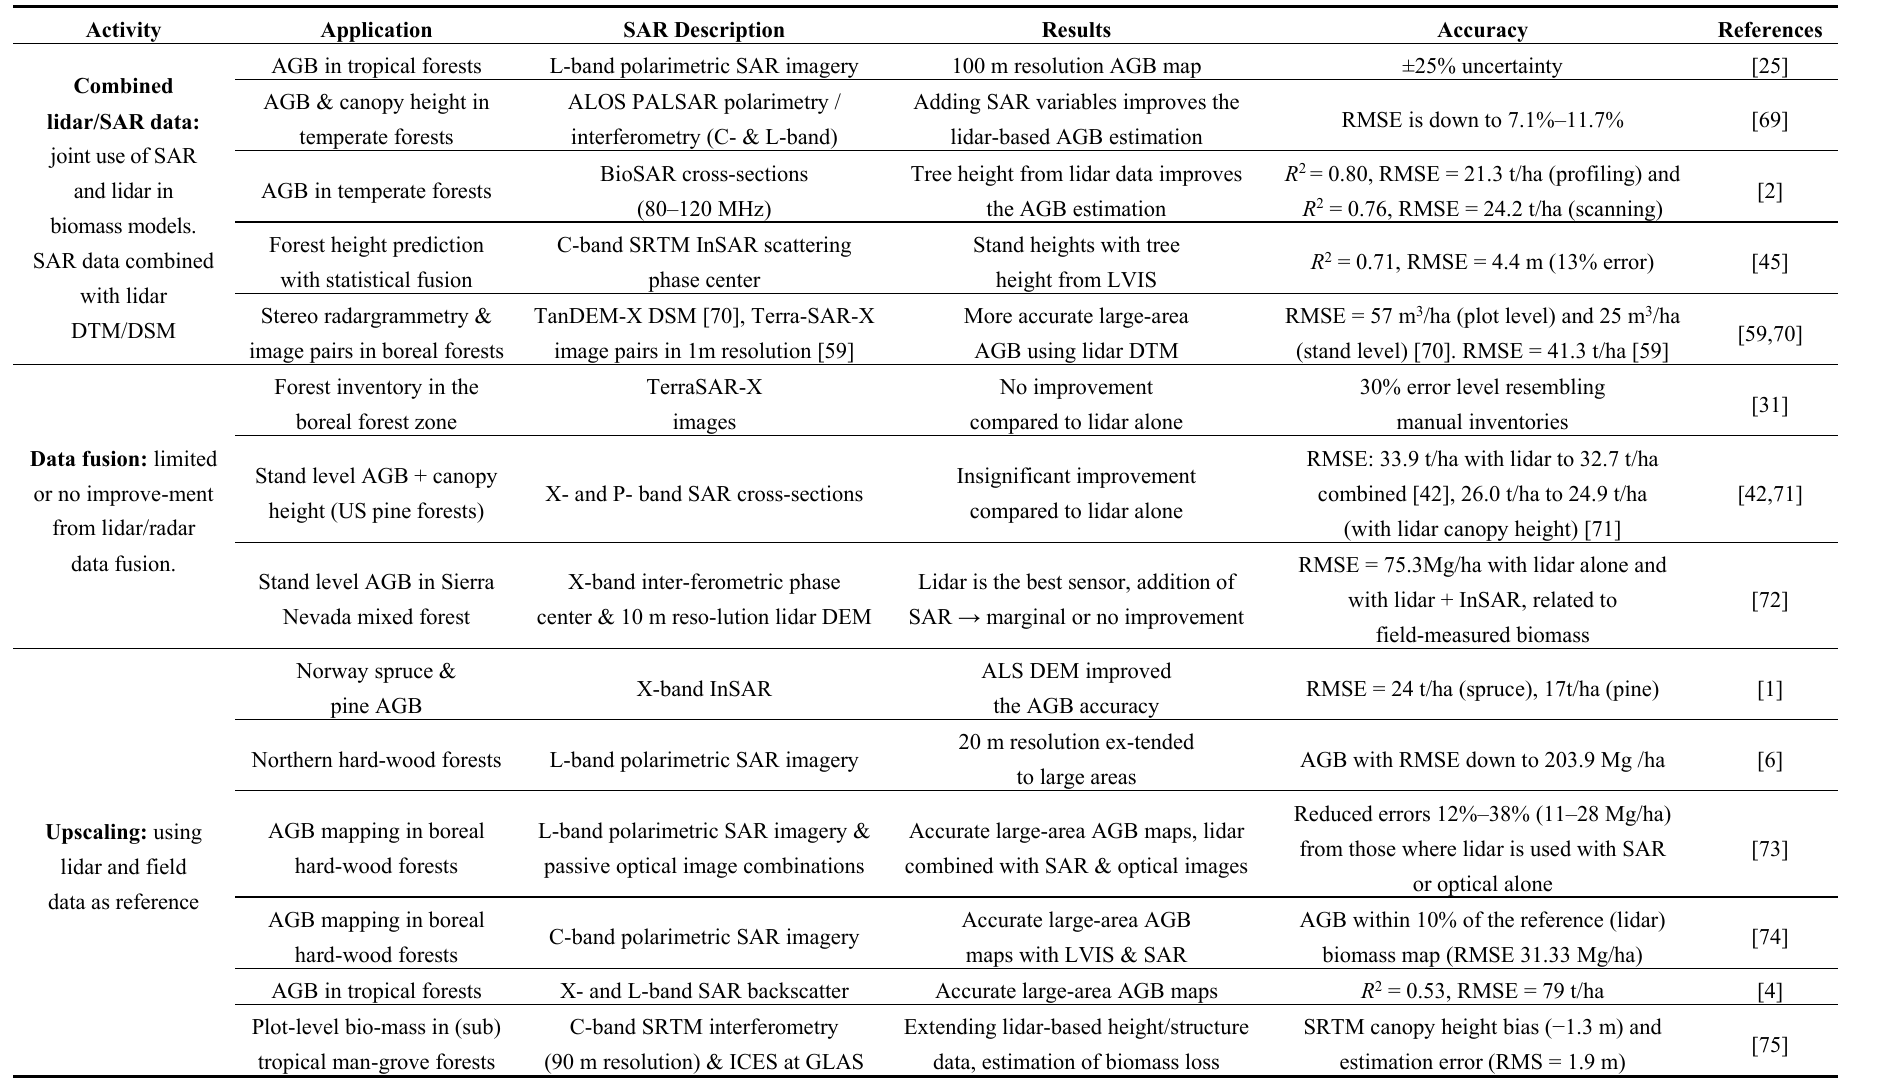
Table 1. Summary of studies of combined use of lidar and synthetic aperture radar (SAR) in biomass estimation. Abbreviations: